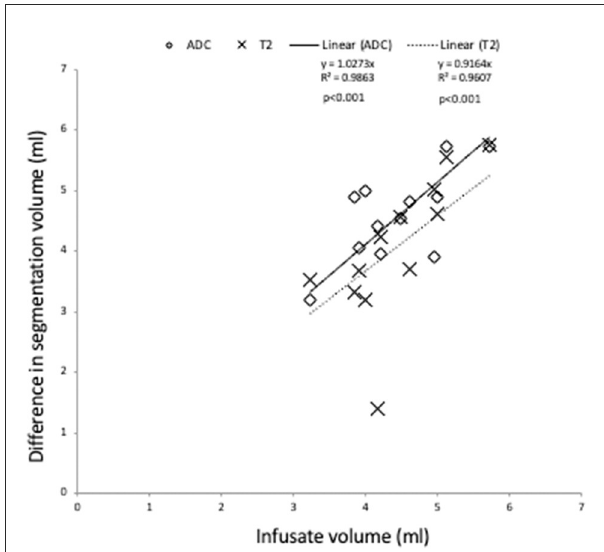
FIGURE3 Association of change in segmentation volume pre and post infusate with infused volume. A significant correlation is observed for the infused volume and the difference in segmentation volume defined by ADC and T2W ( p < 0.0001).